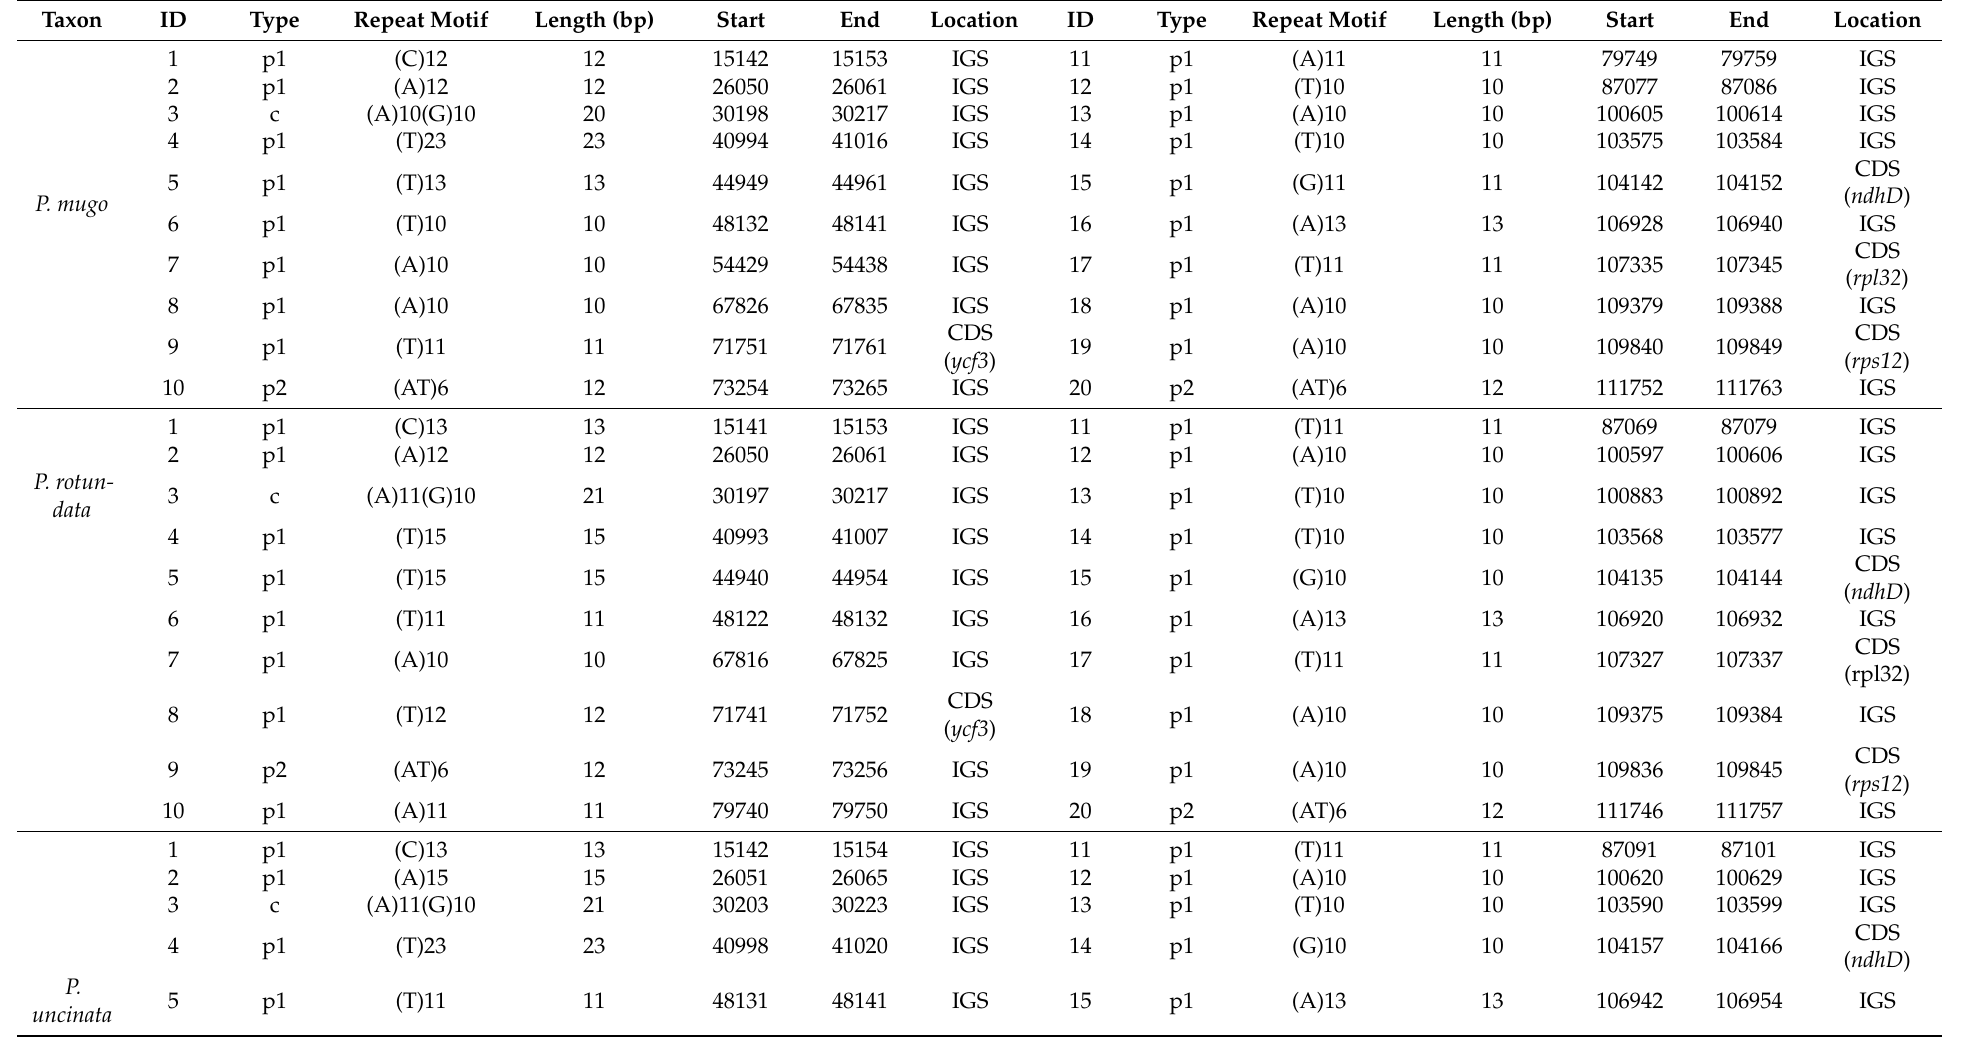
Table 3. Estimates Simple sequence repeats (SSRs) identified in the P. mugo , P. rotundata , P. uncinata and P. sylvestris chloroplast